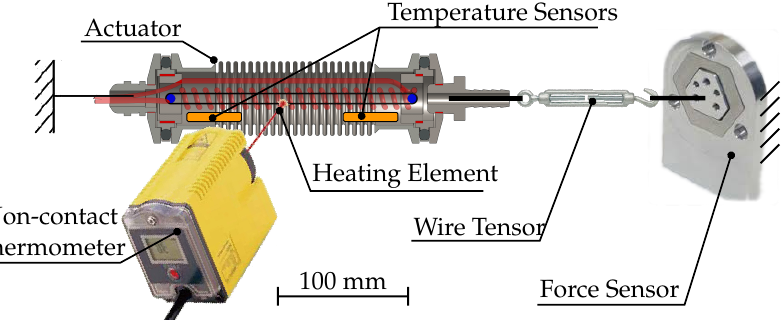
Figure 5. Zero-Flow experiment setup. Table 1. ZFSMALA experiment components and specifications.